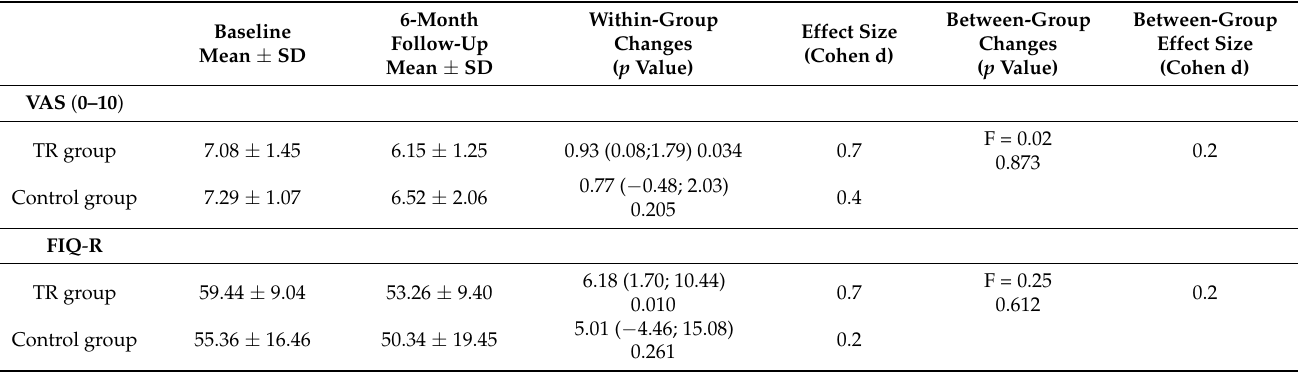
Table 2. Within-group changes, between-group changes and effect sizes for primary and secondary outcomes at baseline and 6-month